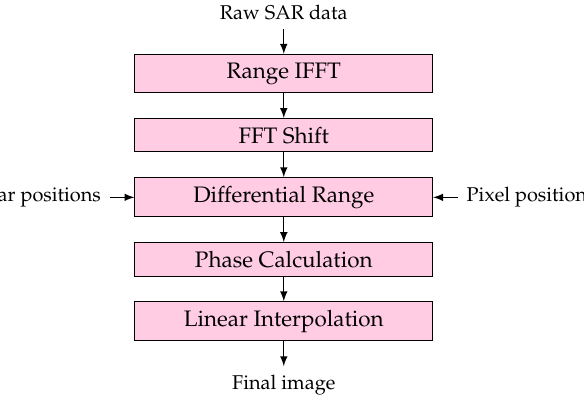
Figure 8. Block diagram of the backprojection algorithm, from